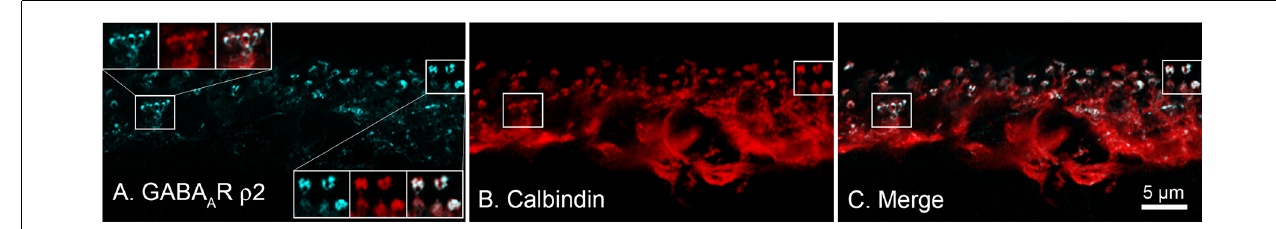
FIGURE 6 | Horizontal cells express ρ -subunit-containing GABA receptors in their synaptic endings in the mouse retina. (A) Immunolocalization of the ρ 2 subunit (blue). (B) Horizontal cell marker, calbindin immunoreactivity (red). (C) Merged image shows that expression of ρ 2 subunits is limited to the tips of horizontal cell synaptic endings that invaginate rod and cone photoreceptor terminals (Insets show magnified images in Panel (A) , upper left, of a single cone pedicle; lower right, 3-rod spherules). Figure modified from Grove et al. (2019).